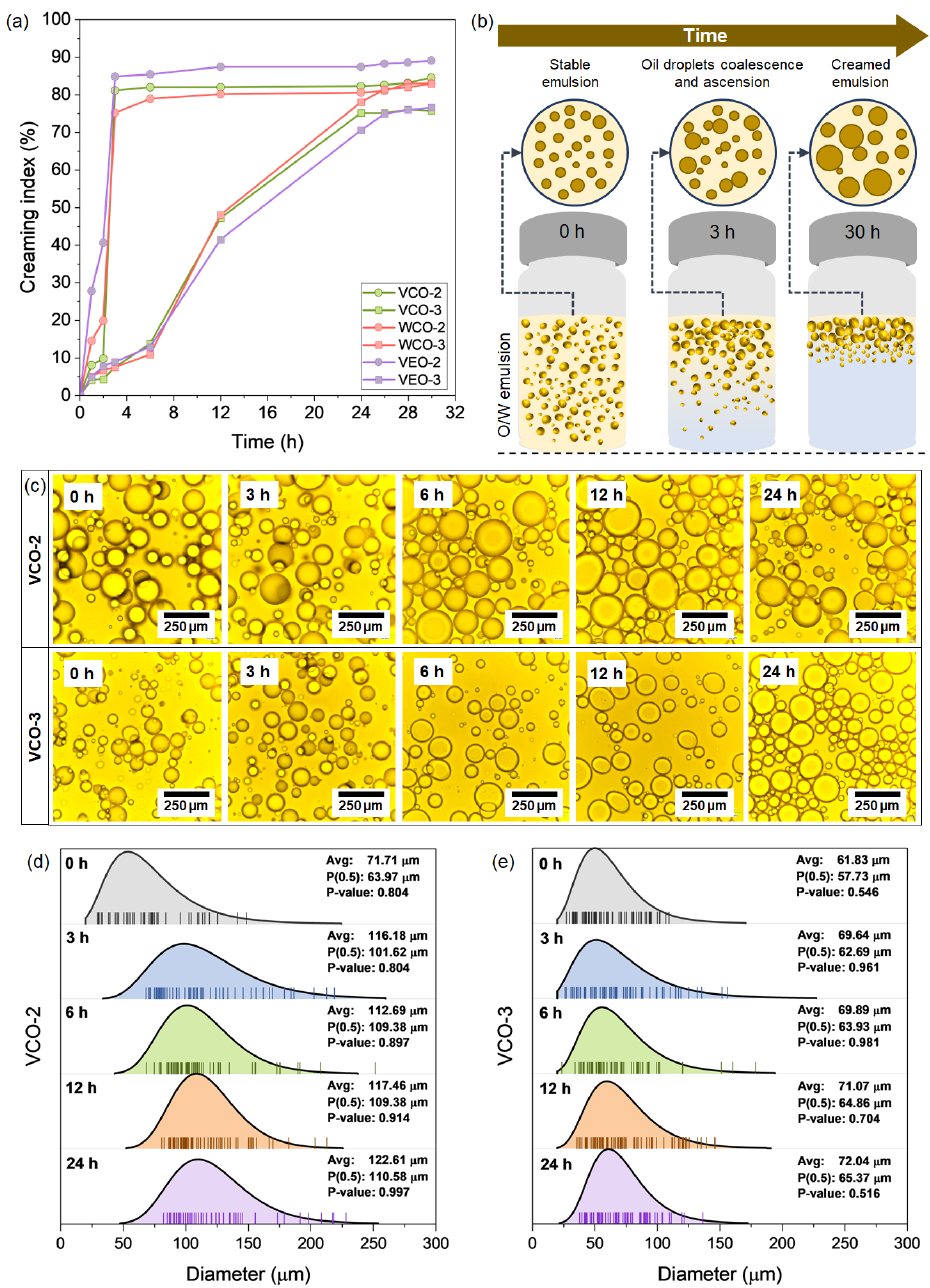
Figure 2. ( a ) Average results of creaming index evaluated at different times for the different O/W emulsions; ( b ) schematical representation of the creaming process occurring in the O/W emulsions over time; ( c ) examples of fluorescence microscopy images for the VCO-2 and VCO-3 emulsions showing the oil droplet growing over time; and statistical distribution of the oil droplet size over time for the case of ( d ) VCO-2 and ( e ) VCO-3 emulsions. Nonetheless, VCO-3 emulsion presented droplet sizes significantly lower than